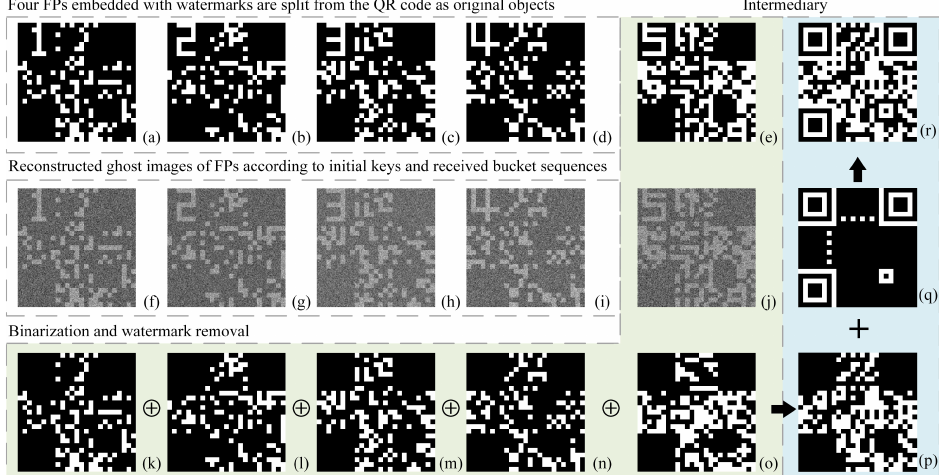
Figure 3. Simulation results for t = 4 case. ( a – e ) Five watermarked FPs; ( f–j ) are the recovered ghost images; ( k – o ) five binary FPs with the watermarks being removed from ( f – j ); ( p ) the composite image synthesized from ( k – o ) by using the cascade ablation strategy; ( q ) the function patterns of a QR code of Version 2; ( r ) the sum of ( p , q ), i.e., the recovered QR code